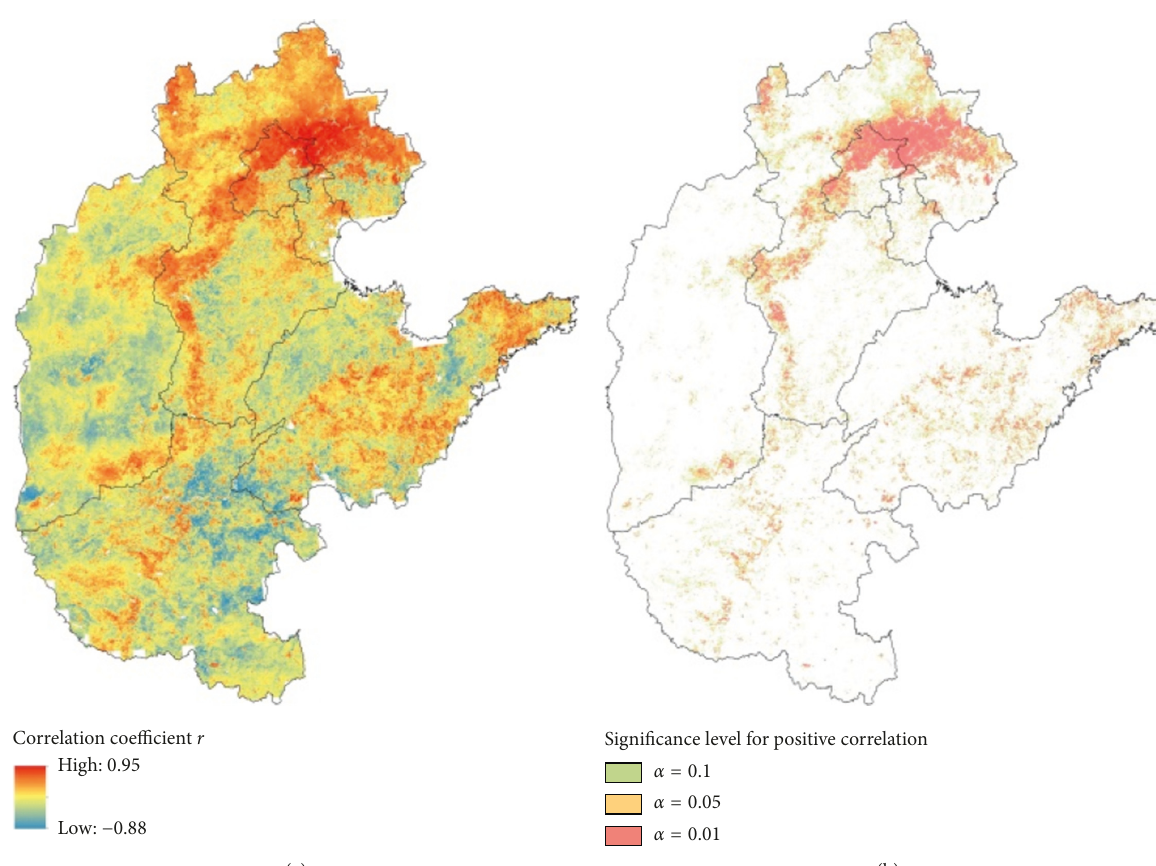
Figure 9: Spatial distribution of correlation analysis between SMAI and VCI in North